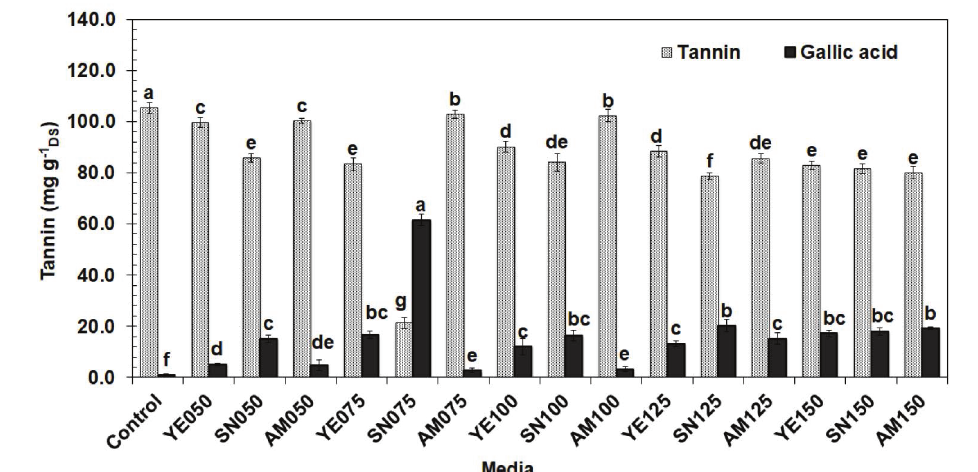
Fig. 1 – Remaining tannin and released gallic acid contents in the BTP fermented with different supplementary nitro- gen. Initial tannin content in BTP byproduct was 156.4 ± 2.2 mg g –1